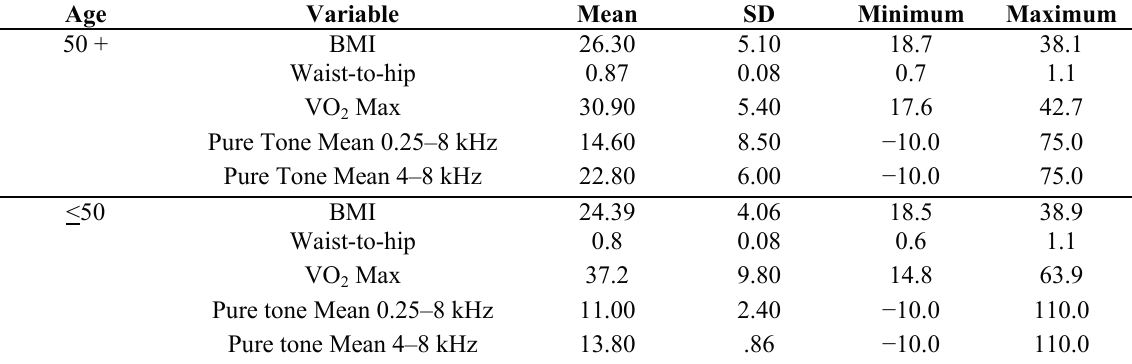
Table 8. Mean measures of health related variables and hearing according to